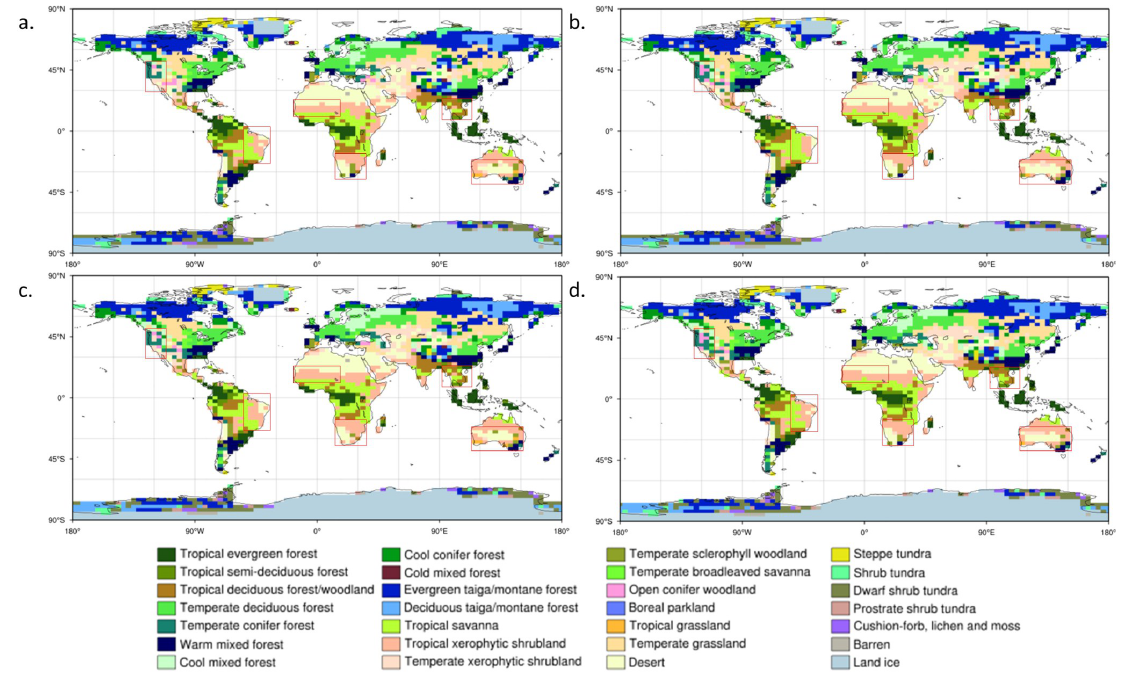
Fig. 6. The predicted biomes for the late Pliocene soil and lake experiments with red boxes to highlight key regions discussed in the text. (a) PRISM3 control, (b) PRISM3 + wet lakes, (c) PRISM3 + soils and (d) PRISM3 + soils + wet